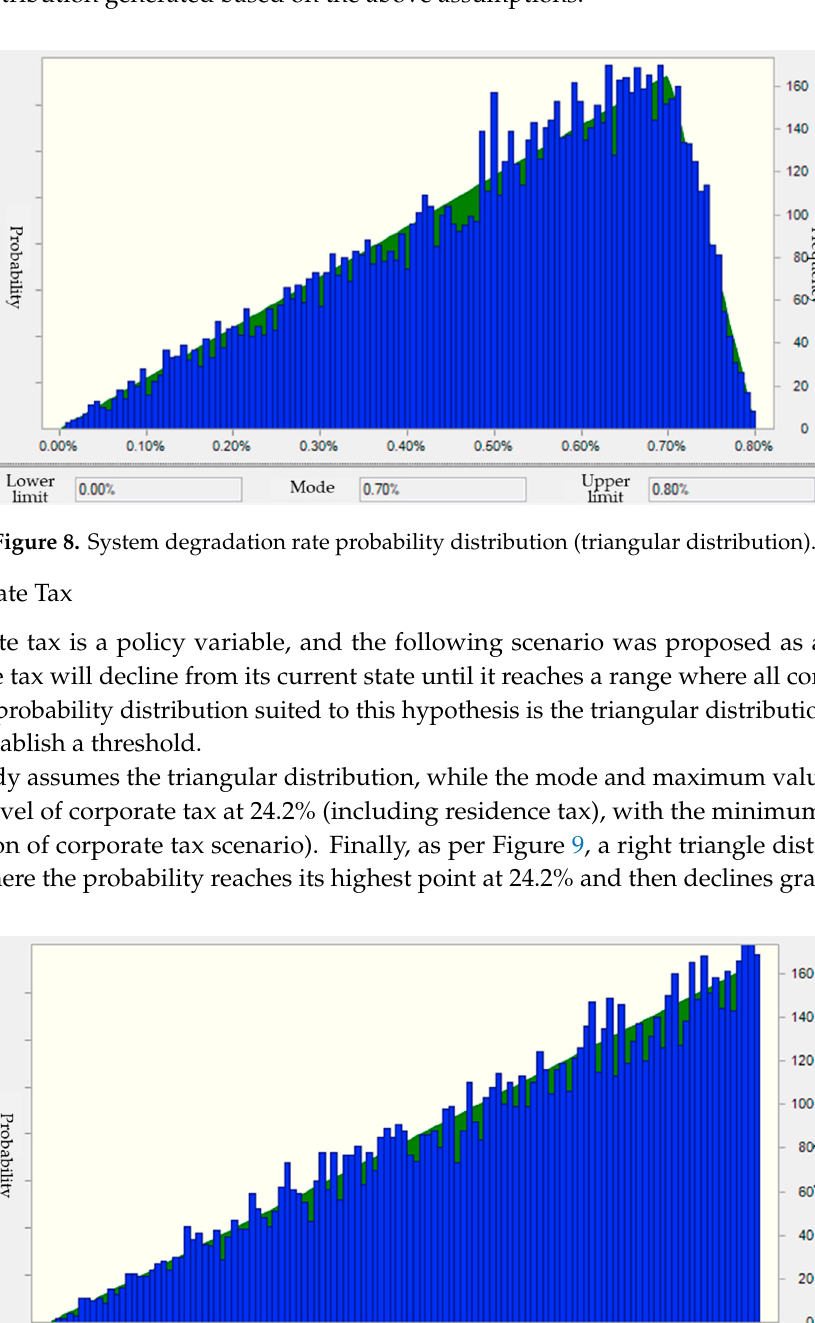
Figure 7. Probability distribution for residential facility CAPEX (normal distribution).